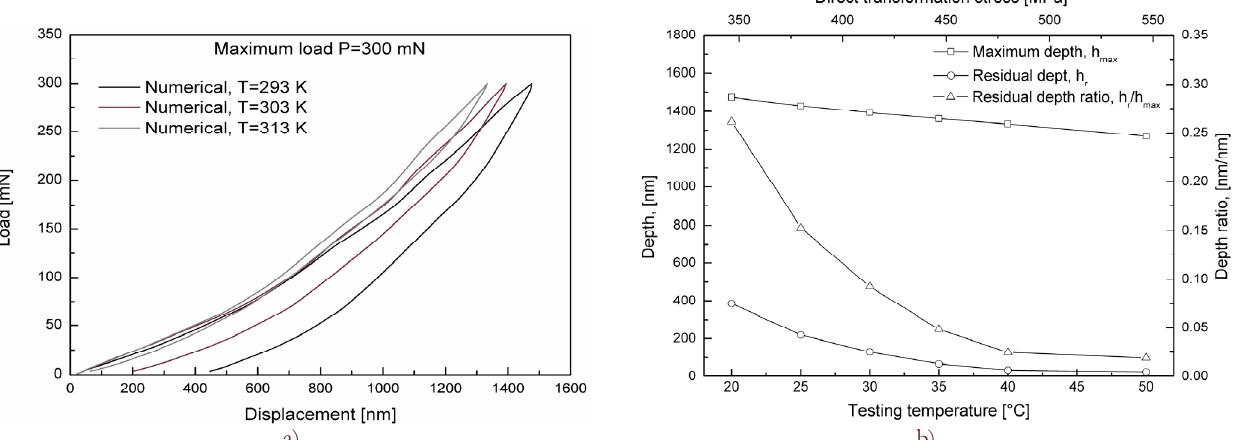
Figure 7. Effects of test temperature on the indentation response of the SMA: a) Load-Displacement curves of the SMA at different temperatures; b) Maximum depth and residual depth vs temperature and direct transformation